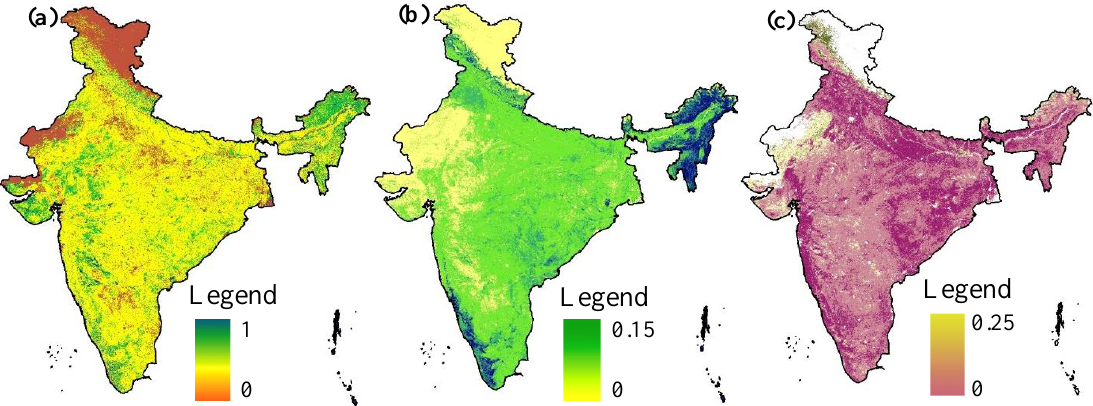
Figure 7. Representing the standard deviation map of the three DHI components from 2001 to 2015 in India, where: ( a ) DHI-cum SD; ( b ) DHI-min SD and ( c ) DHI-sea SD.